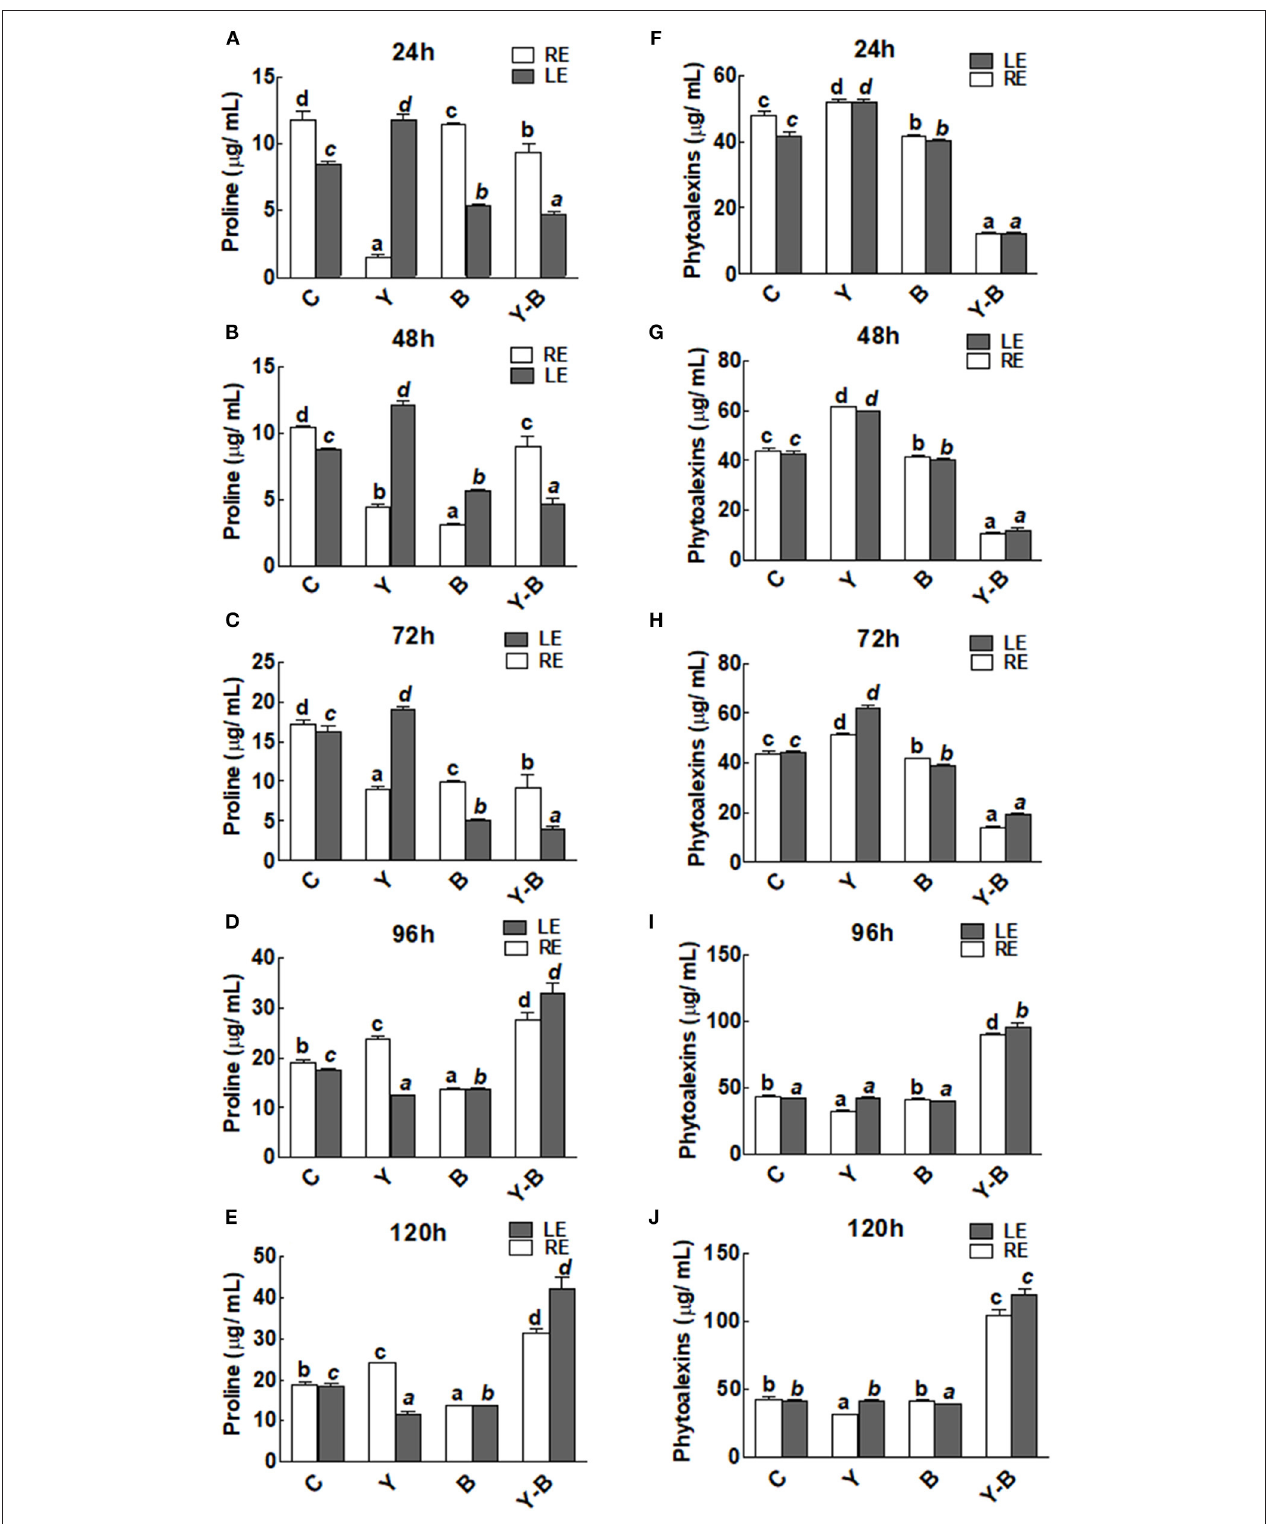
FIGURE 3 | Determination of proline (A–E) and phytoalexins (F–J) in the leaf extracts (LE) and root exudates (RE) of 11-days-old maize seedlings exposed to different treatments, including C (control); Y (yucasin), B ( Bipolaris spp.), Y-B (yucasin- Bipolaris spp.) for the different time duration. Data are mean from three independent experiments with standard error bars. Bars labeled with different letters are significantly different (Duncan test; p < 0.05).